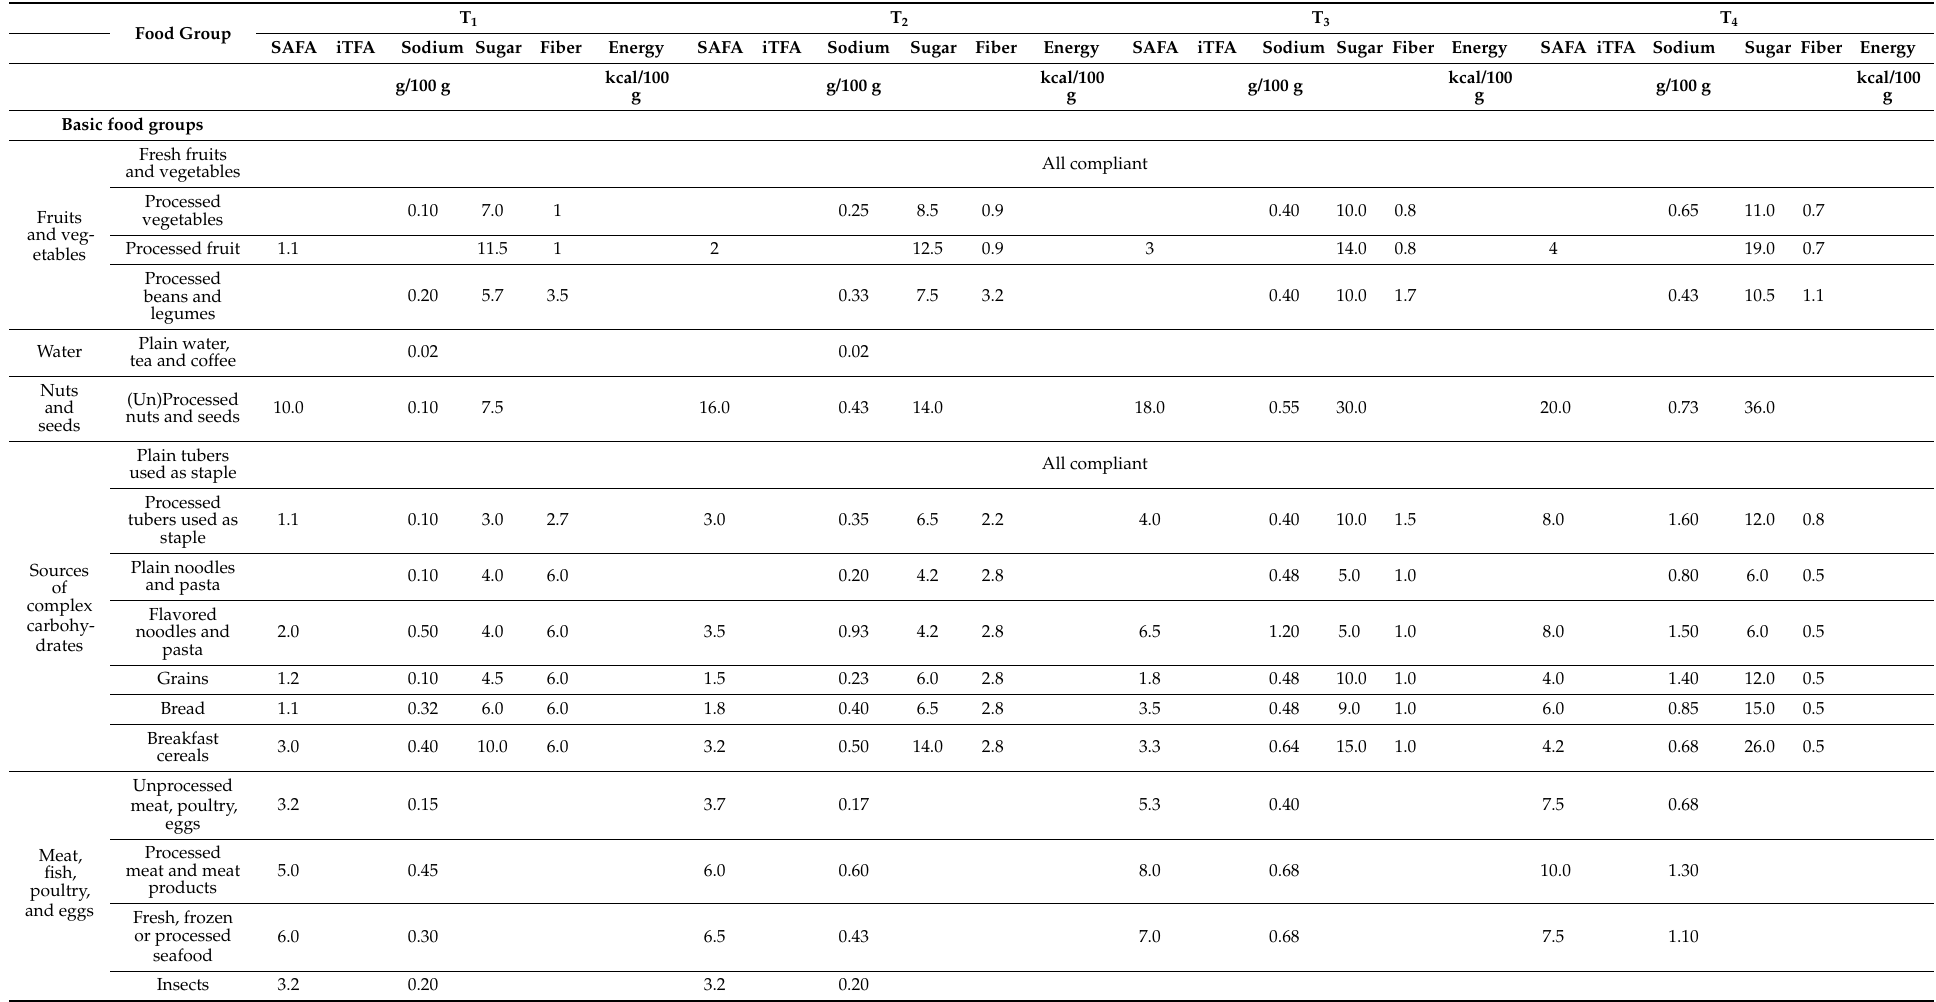
Table 1. Choices five-level criteria for basic and non-basic food groups after the validation and consultation process. To comply with a certain threshold, product nutrient content should be ≤ (for fiber ≥ ) than listed levels for all nutrients. When nutrient levels are not provided, they are considered non-critical for that food group and insignificant. T 1 –T 4 = Thresholds 1–4, SAFA = saturated fatty acids, iTFA = industrially-produced trans fatty